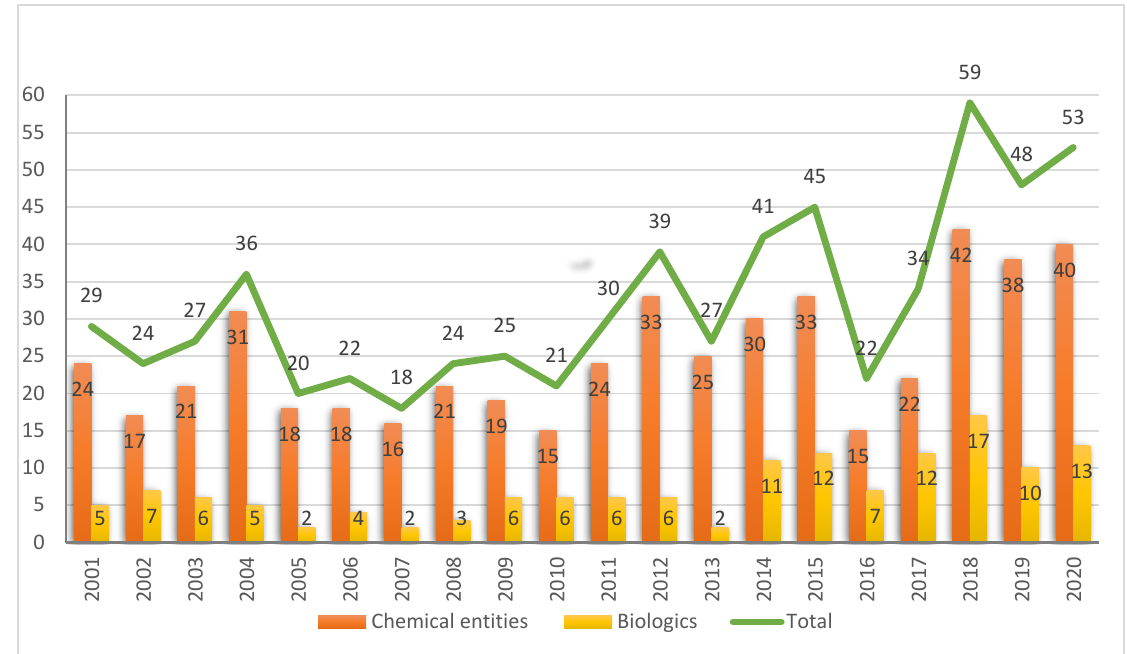
Figure 1. Drugs (New Chemical Entities and Biologics) approved by the FDA in the last two decades [ 1 ].